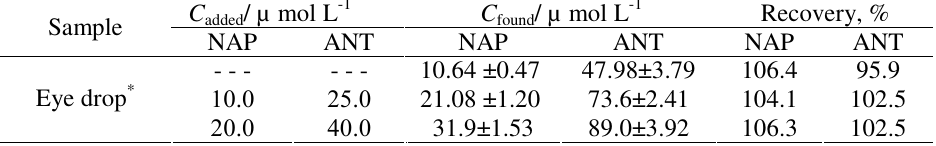
Table 4. Determination of naphazoline and antazoline in a commercial eye drop C / µ mol L -1 C added